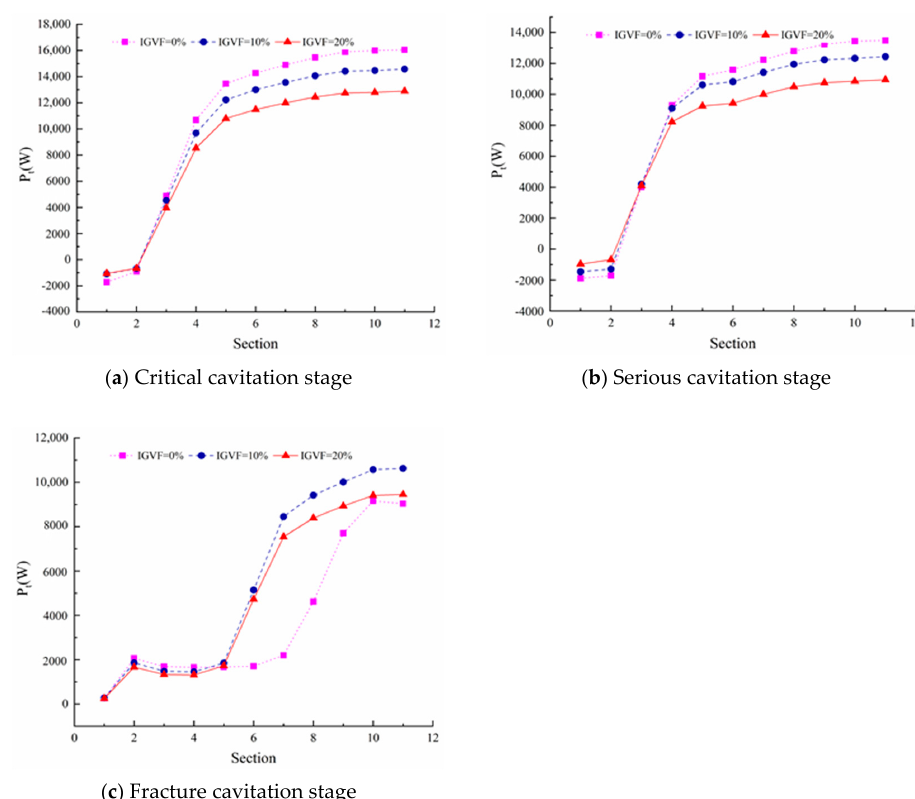
Figure 13. The variation curve of the total pressure power through each section under different IGVFs at each cavitation stage.